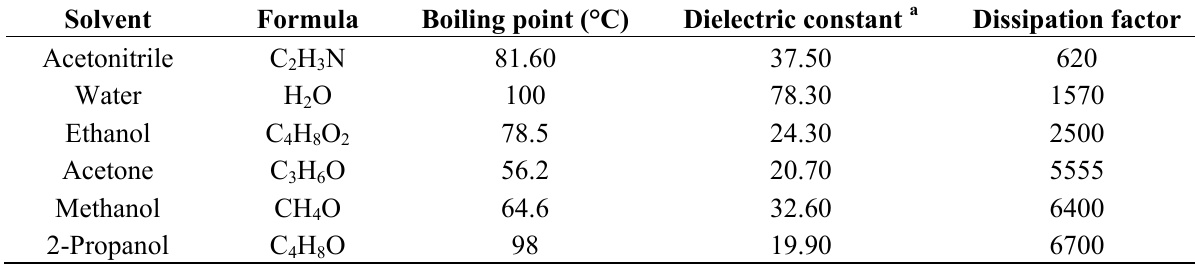
Table 2. Important properties of some solvents commonly used in